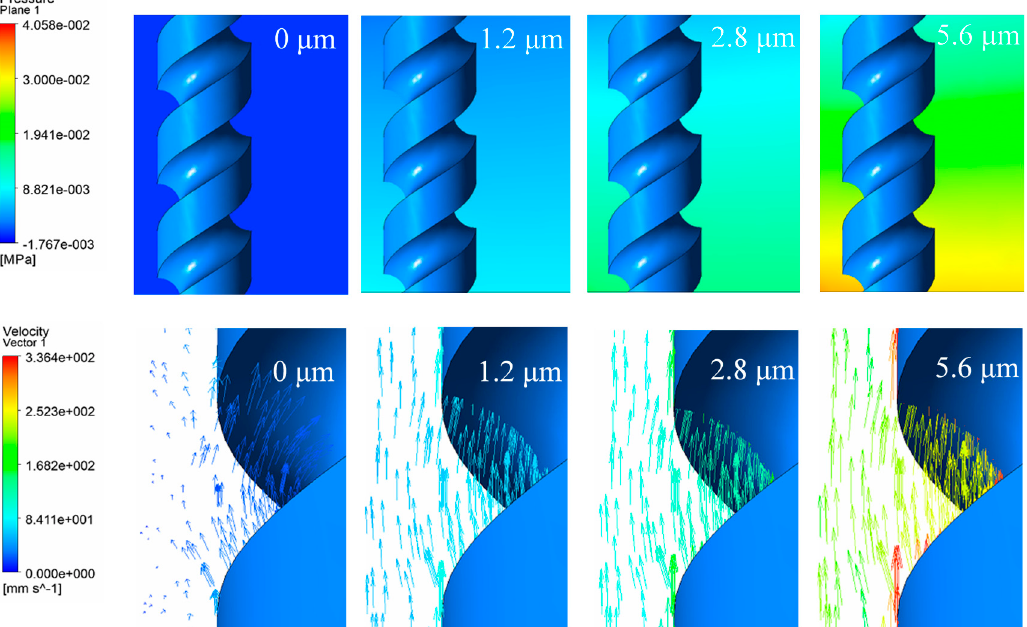
Figure 6. Pressure contours and velocity vector under different amplitude at 1/8T.